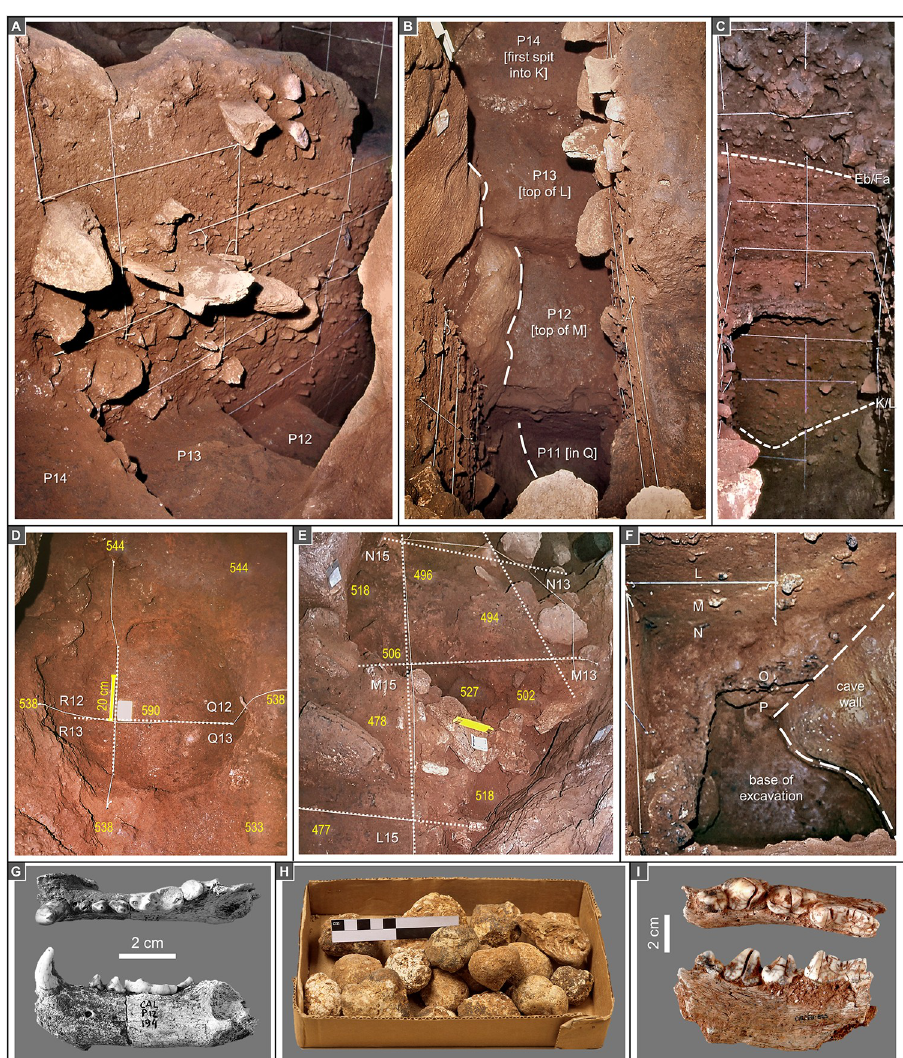
Fig 4. Stratigraphy and disturbance (features and agents). A. The P > Q14-11 profile at the end of the excavation, seen from the angle between Corridor and Back Chamber. B. Zenithal view of the stepped base of the Back Chamber trench at the end of the excavation; the long-dash lines mark the contour of the cave wall; the stratigraphic depth reached in each grid unit is indicated. C. The P11 > 10 profile; the short-dash lines denote the stratigraphic succession’s two major discontinuities. D-E. The large, c . 50 cm-deep burrows penetrating layers Fa-Ja in squares Q-R/12-13 and L-N/13-15; elevations are in cm below datum. F. The base of the P11 > 10 profile seen in oblique view taken from the opposite edge of grid unit P11; note how, along the south and west walls of the trench, layer O formed a thick, hard crust. G. Meles meles (badger) left mandible (P12-194/sc358, layer Fa). H. Sample of the large concentration of hyaena coprolites retrieved in the NE corner of square P11 (P11sc907, layer M). I. Crocuta crocuta (spotted hyaena), right mandible (P11-865, layer